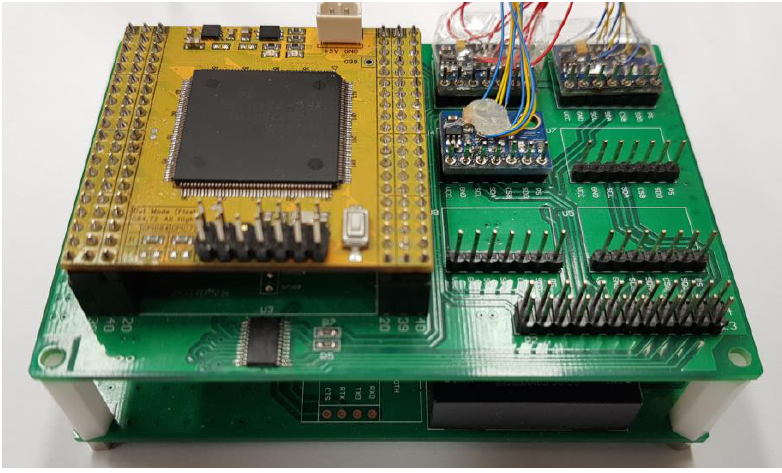
Figure 20. Robot hand control module.